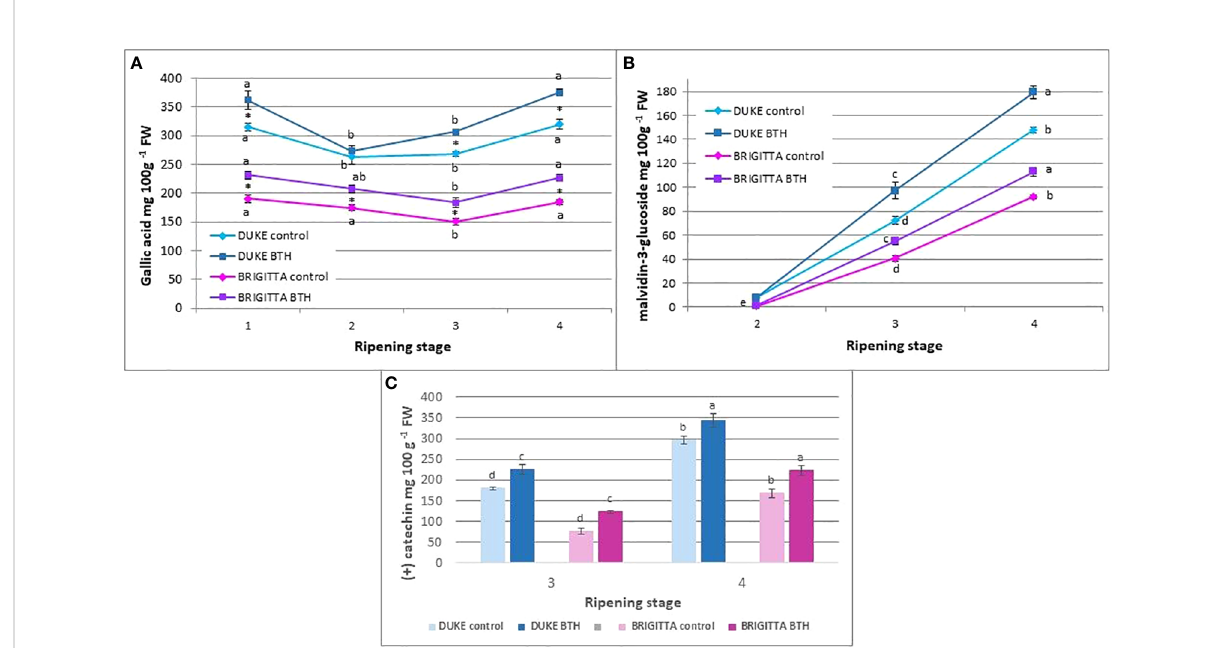
FIGURE 6 Effect of BTH treatment on (A) total phenolics, (B) total anthocyanins and (C) total fl avonoids contents in cv ‘ Duke ’ and ‘ Brigitta ’ . Values represent means ± SE (n = 6). Different letters indicate statistical differences (p ≤ 0.05) among ripening classes and between treatments for each cultivar. In (A) , different letters indicate statistical differences (p ≤ 0.05) among ripening classes for each cultivar, while asterisks indicate statistical differences between treatments (p ≤